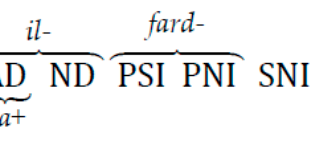
Figure 11. Reference Hierarchy for Iraqi varieties.